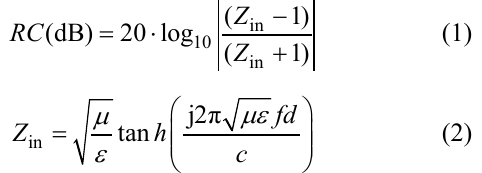
Fig. 9 Calculated theoretical RC values of (a) PAD-2 derived ceramics annealed at different temperatures with a thickness of 1.50 mm and (b) AHPCS-blank, PAD-1, PAD-2, and PAD-3 derived ceramics annealed at 1600 ℃ with a thickness of 1.50